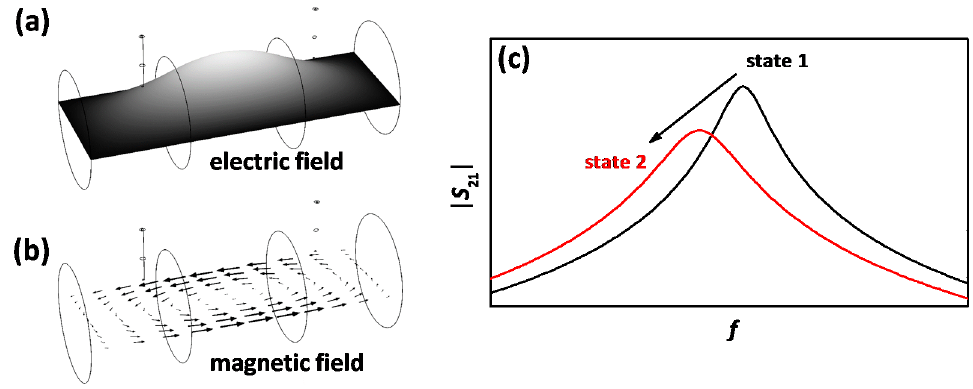
Figure 2. Simulated ( a ) electric field strength (high: light, low: black) and ( b ) magnetic field vectors of the TE 111 mode; and ( c ) example transmission spectrum of the TE 111 mode without NH 3 (state 1, black) and loaded with NH 3 (state 2, red).